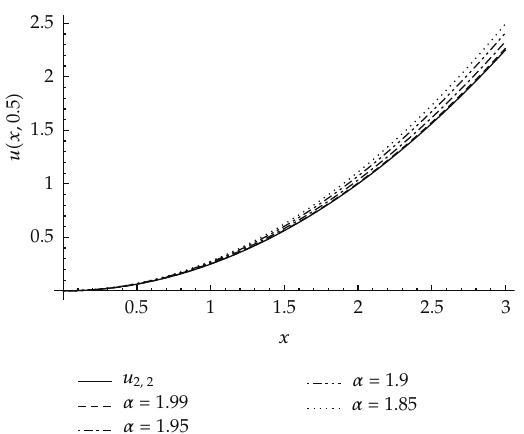
Figure 1: u (cid:2) x, 0 . 5 (cid:3) of Example 4.1 Case 1 for 6th-order HPM approximation as parameterized by α .